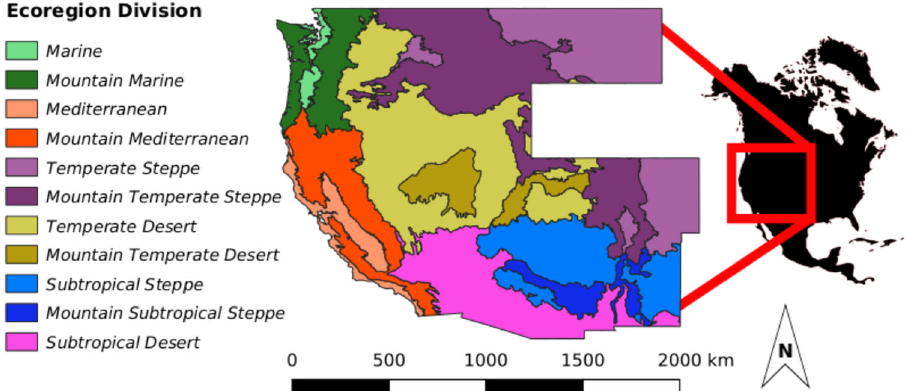
Fig. 1 Study area colored by ecoregion divisions. Ecoregion divisions are differentiated by broad-scale patterns of precipitation and temperature. Our study area spans both the humid and dry domains of the western US. We exclude the state of Wyoming due a lack of data. Table 1 Scienti fi c and common names of the eight most abundant tree species across the western US, listed in order of decreasing prevalence (i.e., the proportion of total number of stems represented by each species across the region).